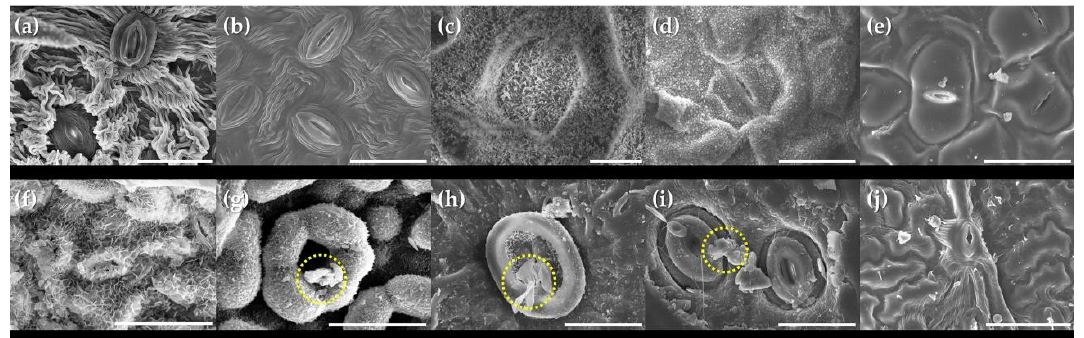
Figure 7. SEM images showing various structural properties of stomata and PM adsorption on abaxial leaf surfaces: ( a ) Aesculus turbinata ; ( b ) Chionanthus retusus ; ( c ) Ginkgo biloba ; ( d ) Liriodendron tulipifera ; ( e ) Magnolia denudata ; ( f ) Styphnolobium japonicum ; ( g ) Taxus cuspidata ; ( h ) Buxus koreana ; ( i ) Euonymus japonicus ; ( j ) Rhododendron schlippenbachii . Note: Yellow circles in image denote PM particles of different size fractions adjacent to the inner wall of stomata or the periphery of guard cells. Scale bars: ( c ) 10 μm; ( a , b , d , f – i ) 30 μm; ( e , j ) 50 μm.